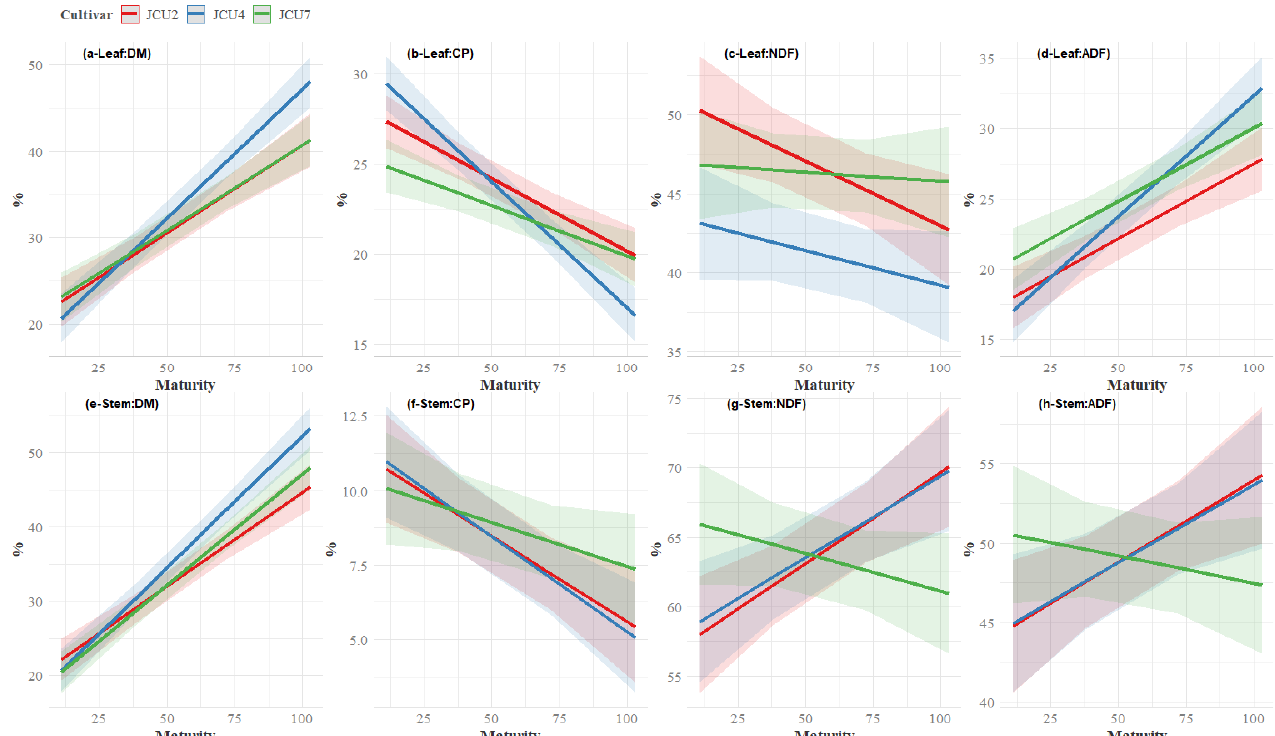
Figure 3. Effect plots for the interactions between cultivar and maturity at harvest on desmanthus leaf and stem portion dry matter (DM), crude protein (CP), neutral detergent fibre (NDF) and acid detergent fibre (ADF) composition. All interactions were significant except the leaf NDF ( p = 0.27) and stem CP ( p = 0.29).